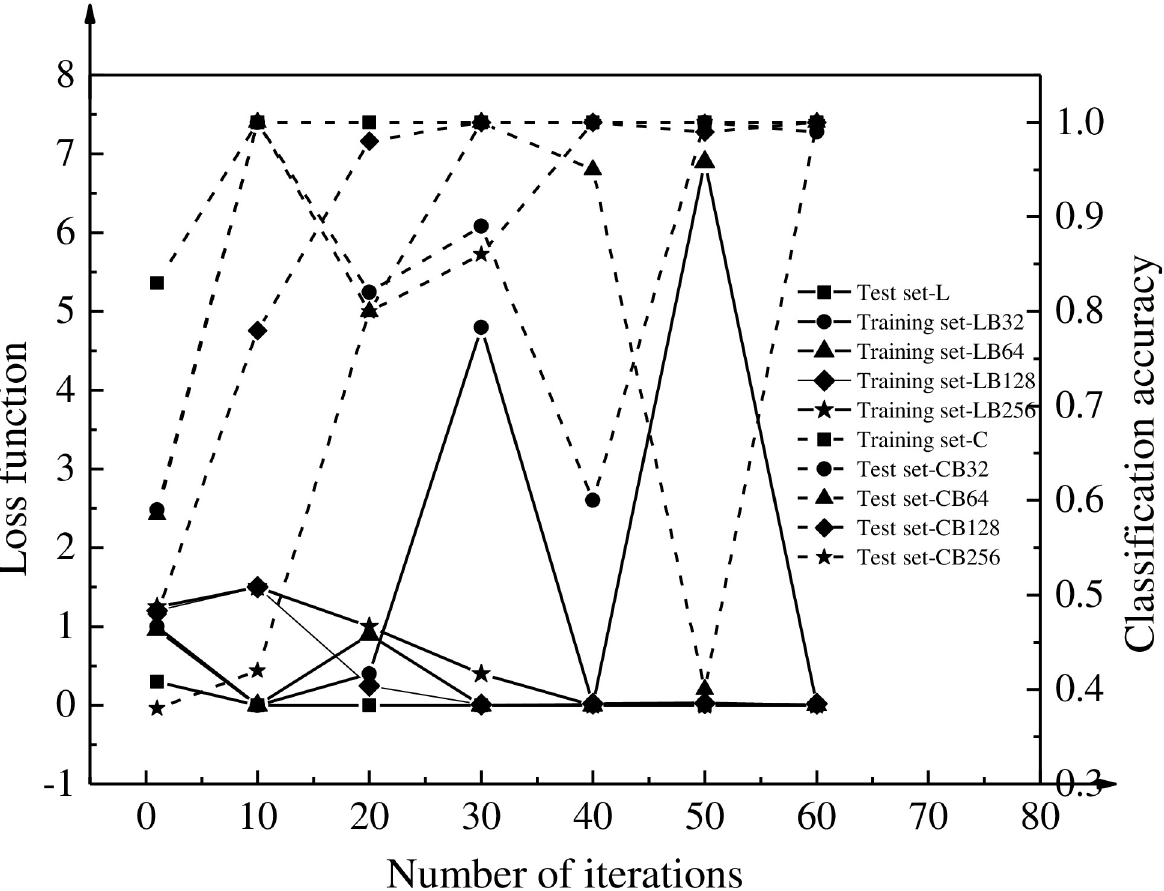
Fig 10. Changes in classification accuracy and loss function when the size of the convolution kernel is 5 � 1. Note: in the legend, L and C refers to the loss function and classification accuracy, respectively.